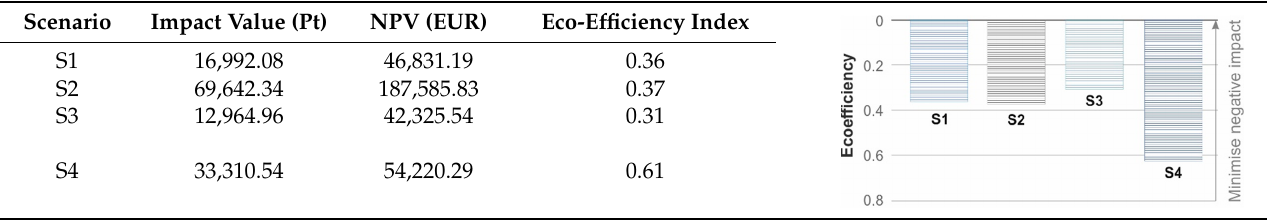
Table 9. Environment costs for lighting life cycle scenarios for year.